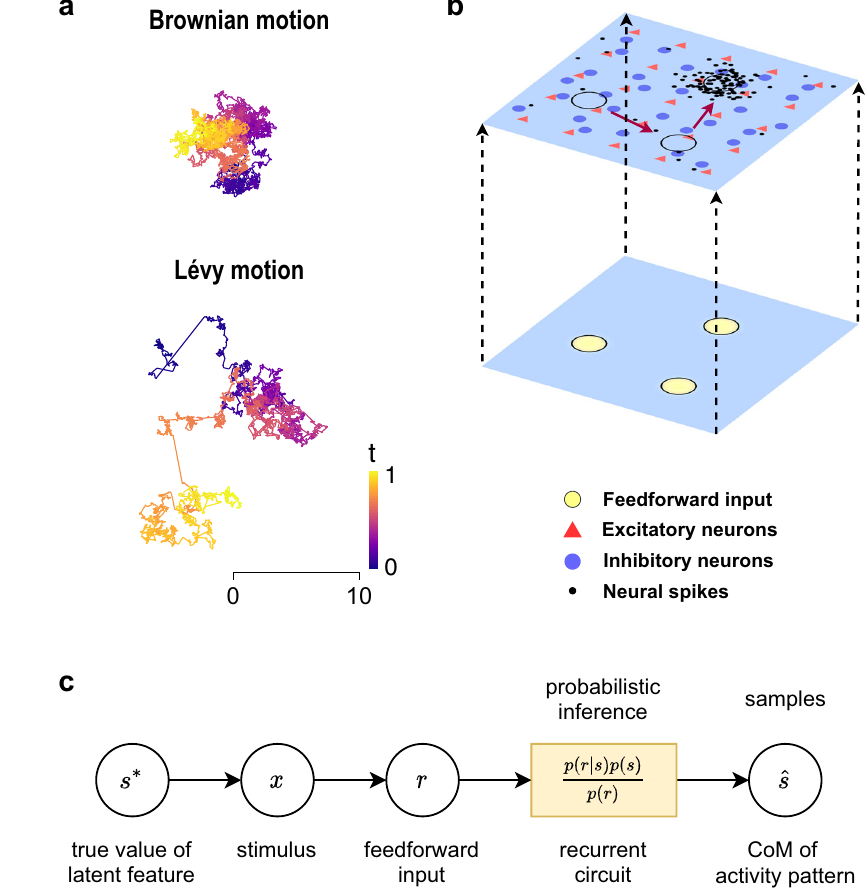
Fig. 1 | Complex spatiotemporal dynamics of neural circuits implement prob- abilisticcomputations.a Typical sample path of a Brownian motion and that of a Lévy motion. The latter consists of clusters of short step sizes that are inter- mittently interspersed by long jumps. In contrast, the Brownian motion lacks such long jumps. Color indicates time. b Schematic diagram of the two- dimensional E-I spiking neural circuit. The circuit consists of recurrently con- nected excitatory and inhibitory neurons spanning a two-dimensional feature